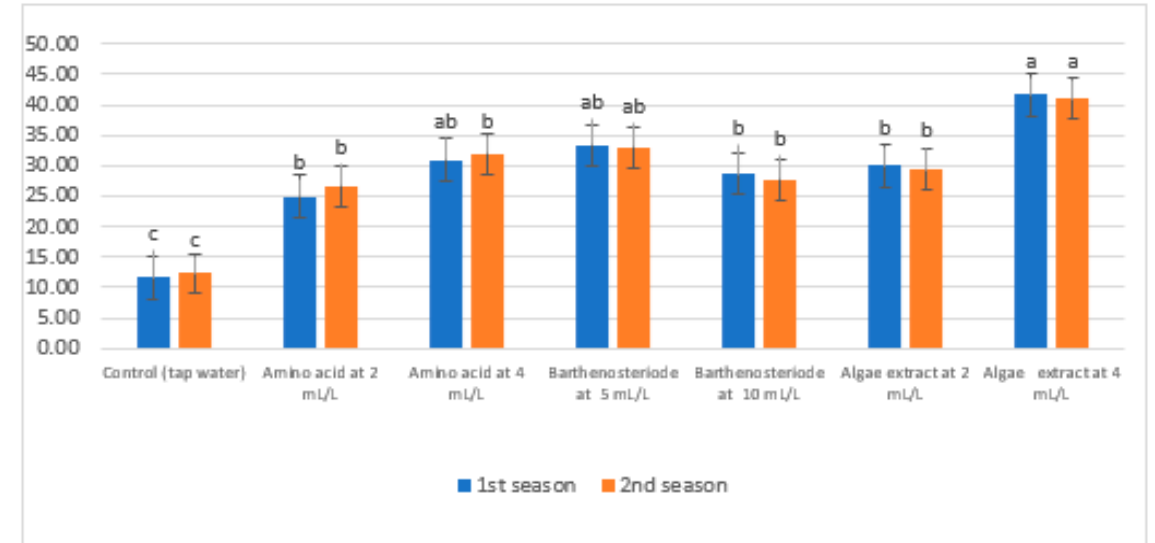
Figure 6. Effect of various bio-stimulant treatments on chia (Salvia hispanica L.) plant total indoles (mg/100 g F.W.) during the 2019–2020 and 2020–2021 seasons. For the same column, means followed by the same letter are not statistically different, according to the Tukey multiple range test.